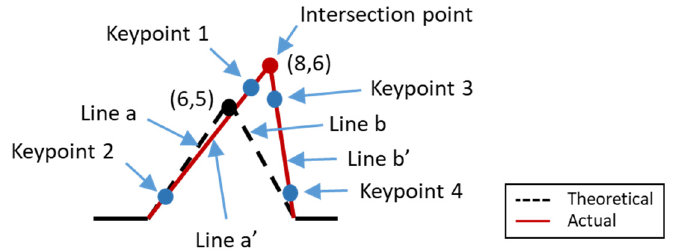
Figure 4. Illustration diagram of compensation.